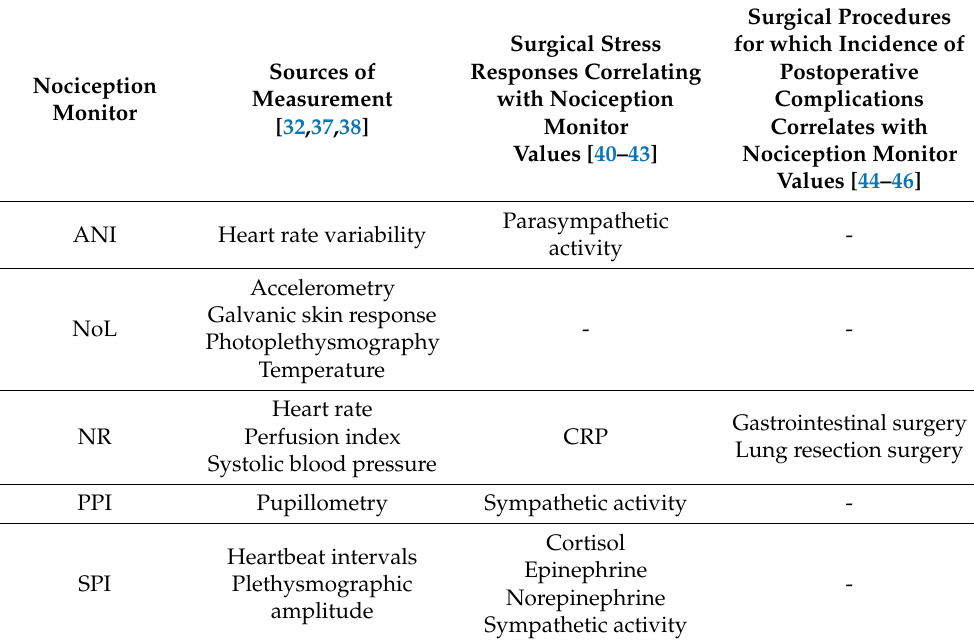
Table 1. Nociception monitors using autonomic